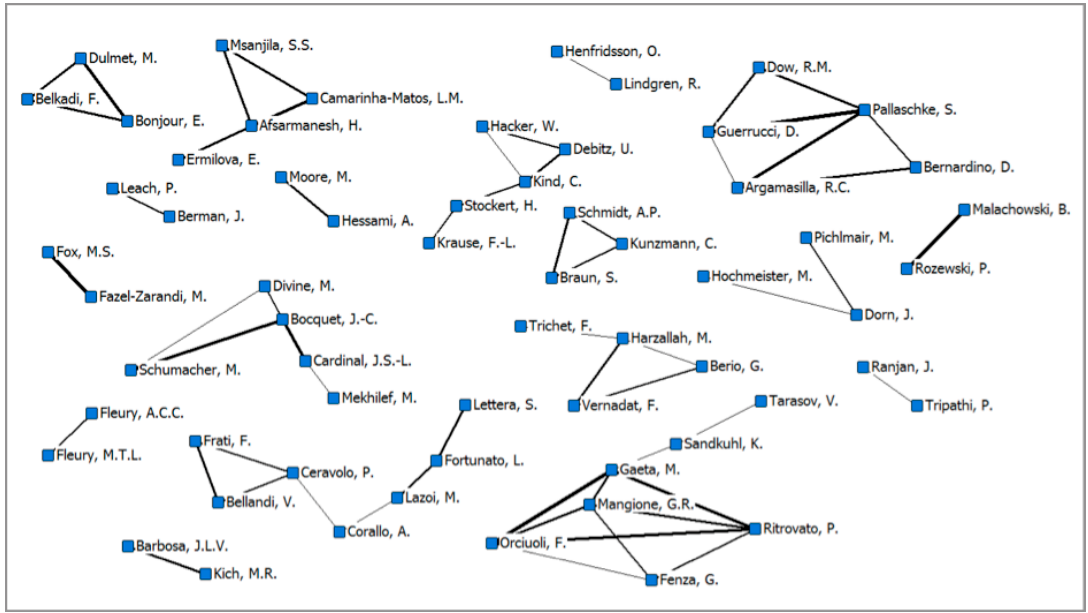
Figure 5. Collaboration between authors in studies that address competence-based management.